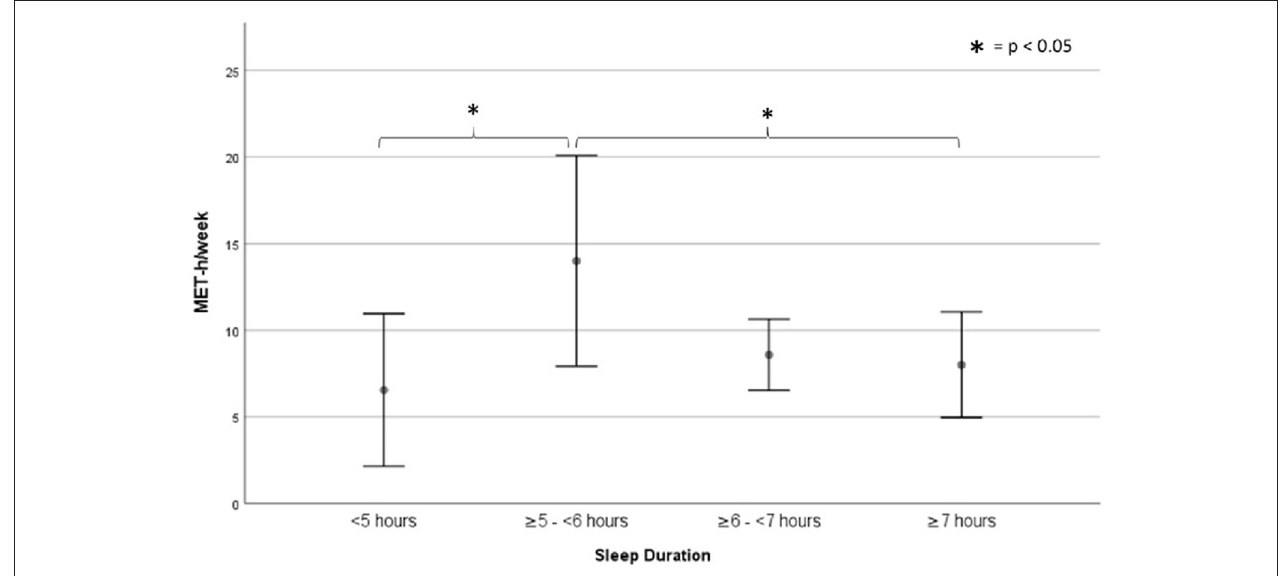
FIGURE 1 | Sub-cohorts’ activity levels based on sleep duration subgroups. Data are displayed as means and 95% confidence intervals.